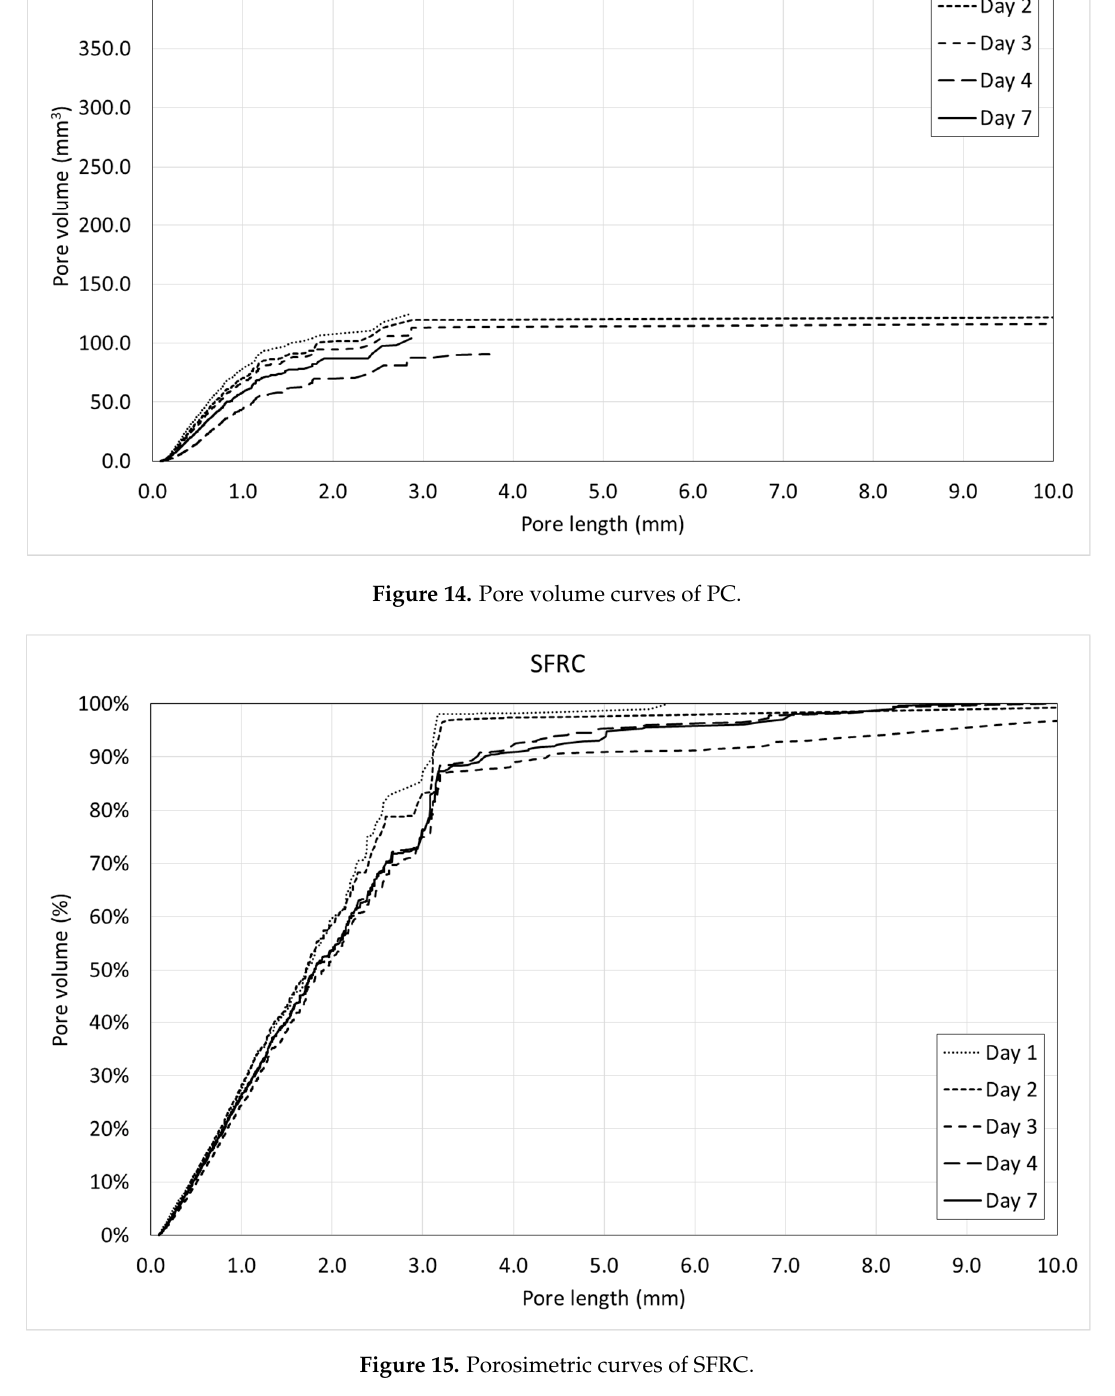
Figure 15. Porosimetric curves of SFRC.